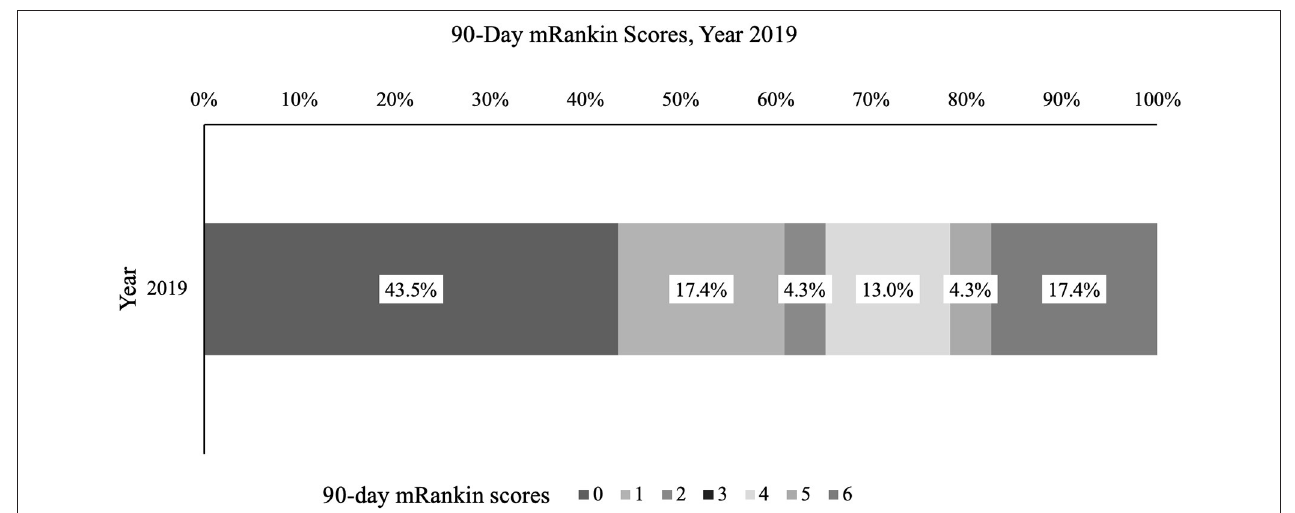
FIGURE 5 | Ninety day modified Rankin Score, %. Percentage of stroke patients with given mRankin score for 2019 is